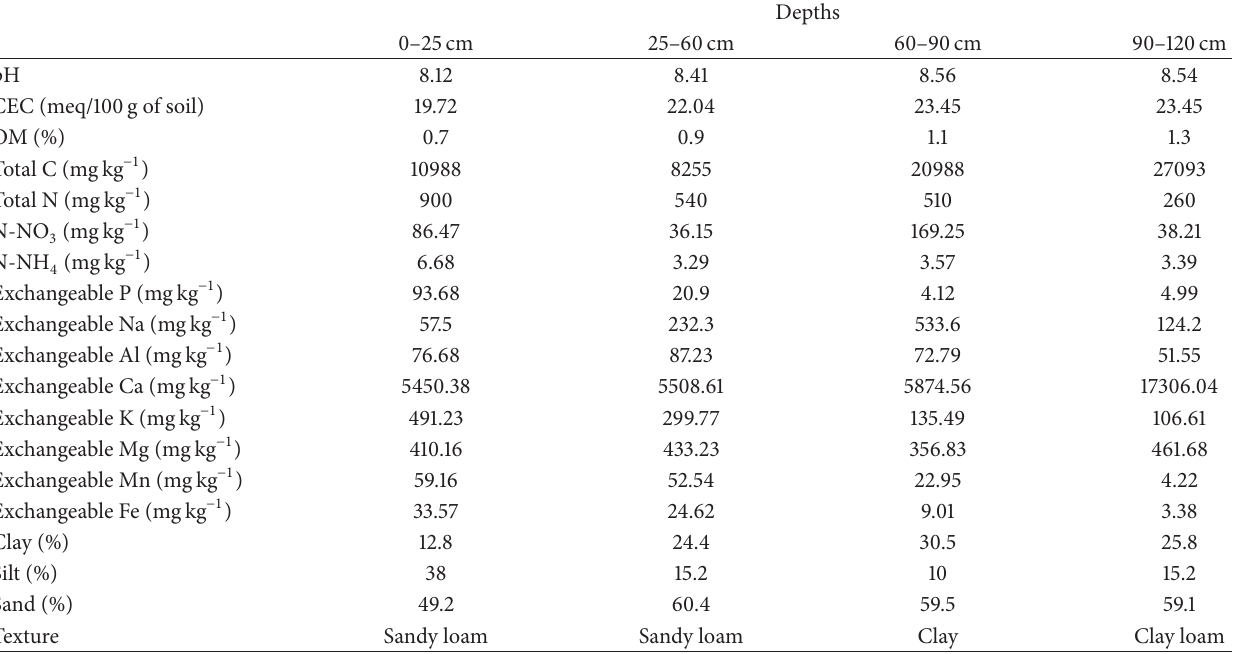
Table 1: Physiochemical properties of iso-humic soil from Chott